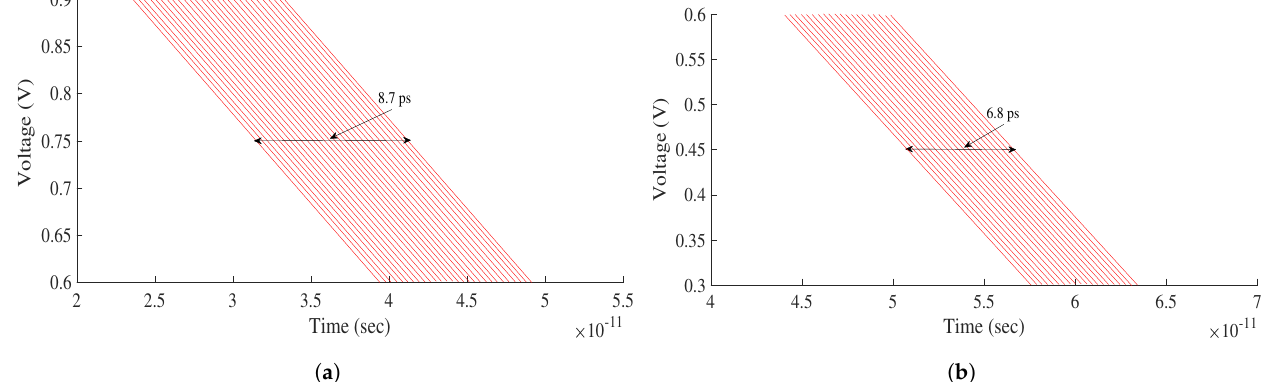
Figure 10. Jitter of the ( a ) DAC-based DCO at 2.2GHz, ( b ) Controller-based DCO at